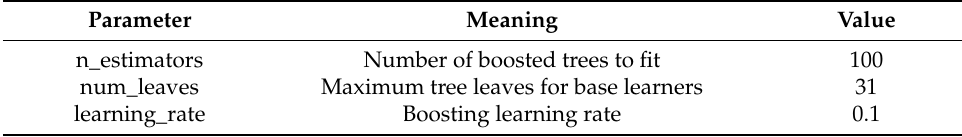
Table 3. Parameter settings of